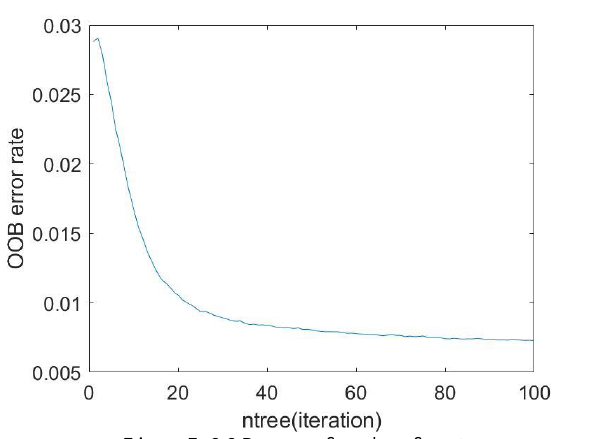
Figure 7. OOB error of random